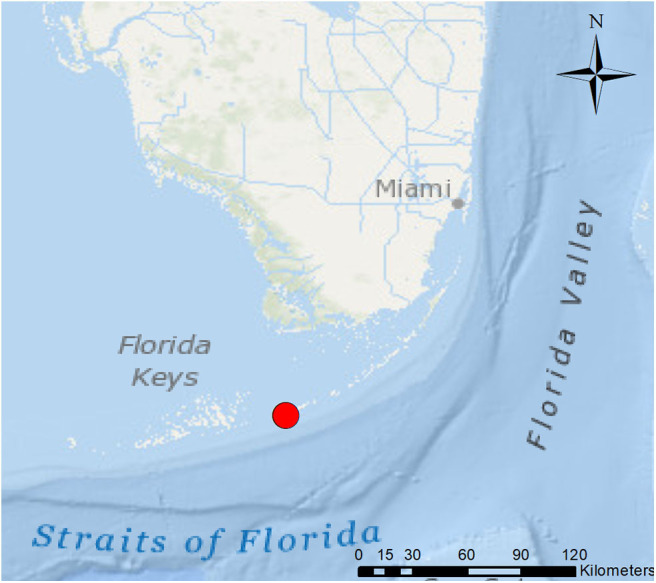
March 2, 2005 Steno bredanensis live mass stranding location on Atlantic Ocean side of Marathon Key, Florida (red circle; 24.71317N, −81.0535W). *Frontiers Media SA remains neutral with regard to jurisdictional claims in published maps and institutional affiliations.